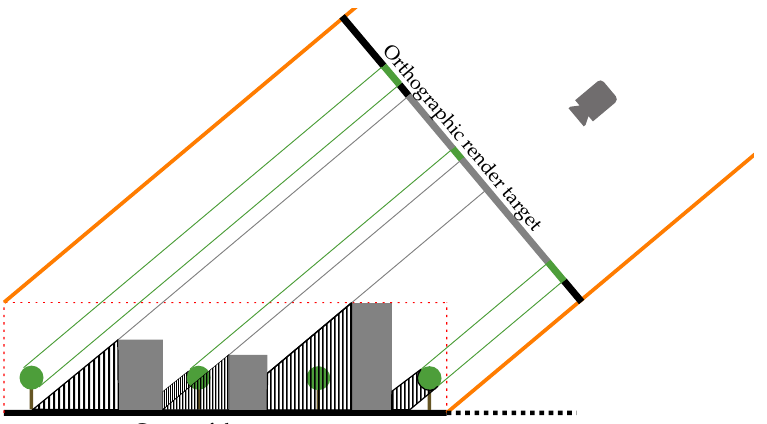
Figure 2. Orthographic render target based on orthographic camera showing the directly sun-lit, projected area of urban obstacles. Urban trees are shown in green and buildings in gray. The obscured, shaded areas are marked by the black pattern. The scene is drawn according to a 40° solar altitude angle of the sun ( β ,